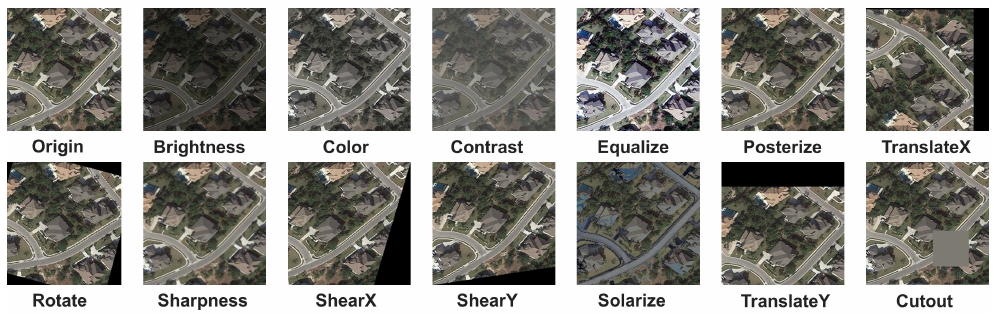
Figure 2. Strong augmentations used in remote sensing images.